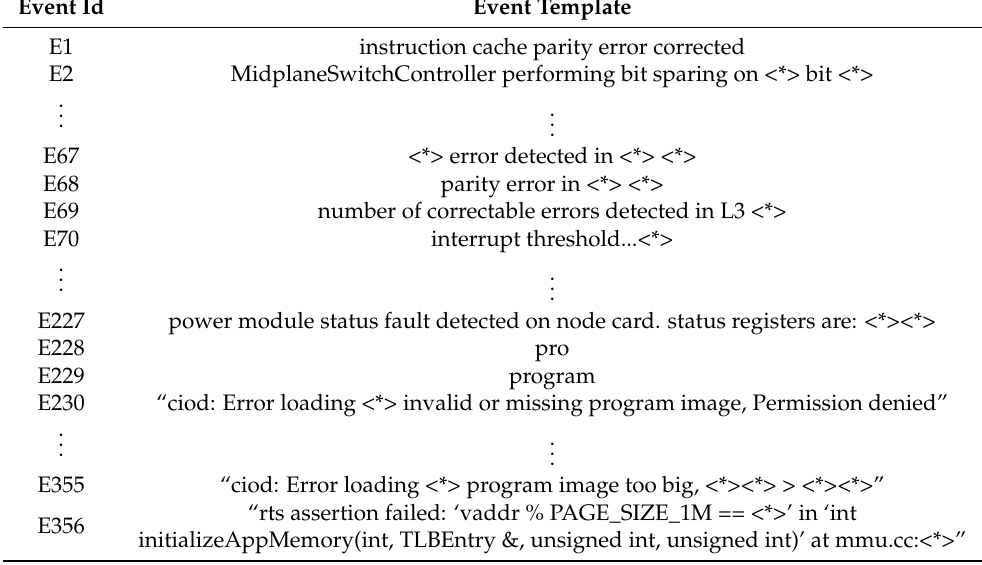
Table 2. Cleaned BGL log templates.